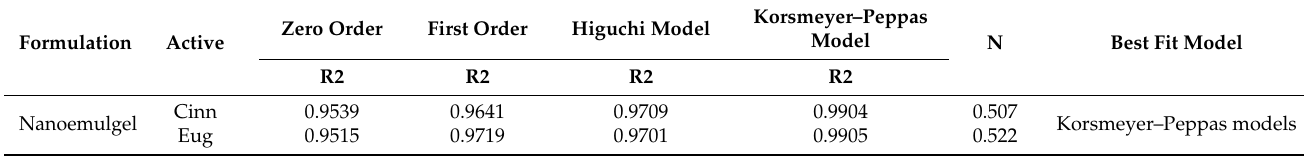
Table 4. Kinetic models used for mechanistic studies of Table 4. kinetic models used for mechanistic studies of nanoemulgel.